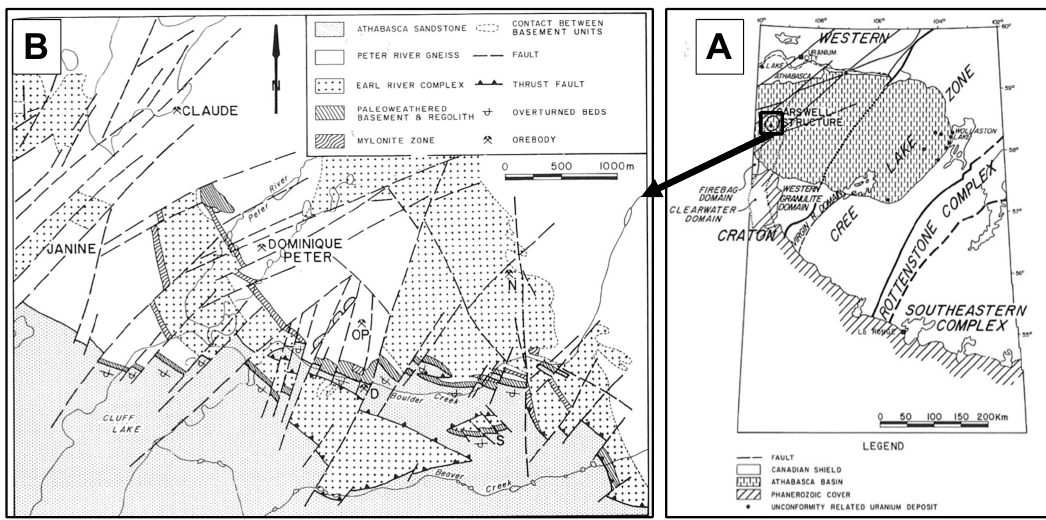
Figure 1. ( A ) Location of the Carswell structure in the Athabasca Basin (modified from [24]); ( B ) Blow up on the Dominique Peter ore deposit in the Carswell structure (modified from Bruneton